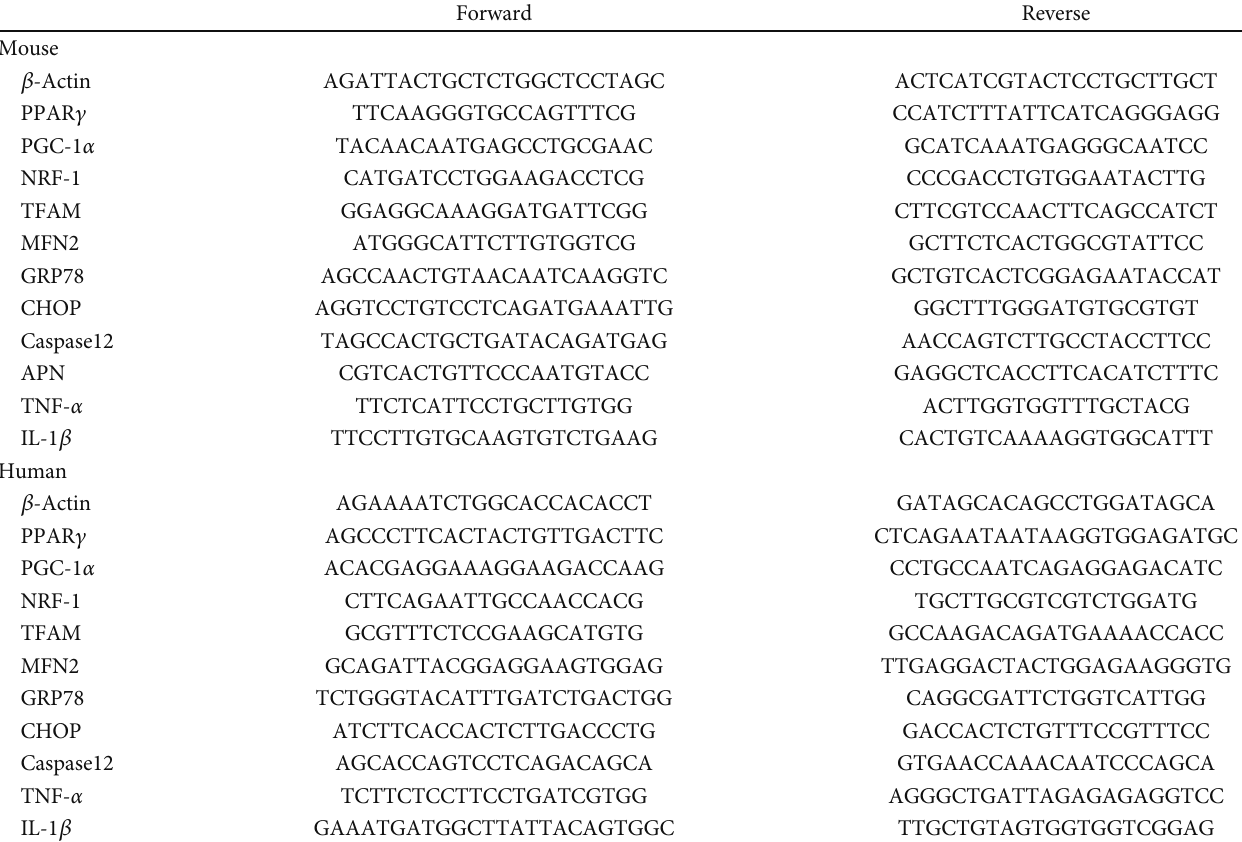
Table 1: Sequences of primer pairs used for ampli fi cation of mRNA by real-time